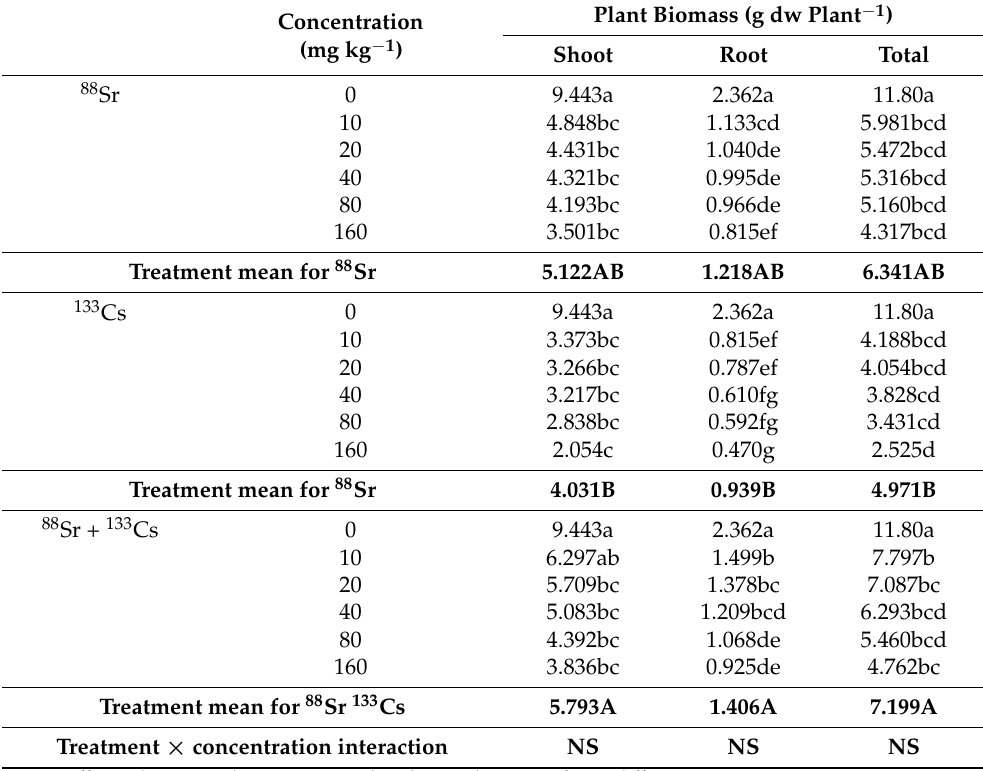
Table 2. Effect of 88 Sr, 133 Cs, and 88 Sr + 133 Cs on the biomass distribution of cucumber. Plant Biomass (g dw Plant − 1 ) Concentration (mg kg − 1 ) Shoot Root Total 88 Sr